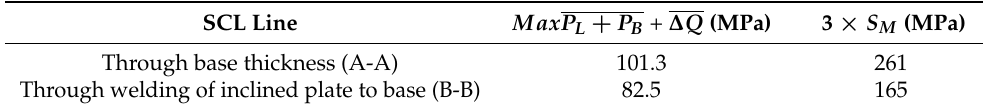
Table 2. Primary membrane + primary bending + secondary stresses in the SCL lines of the TLIC door (Al 6061 T6). SCL Line MaxP L + P B + ∆ Q (MPa) 3 × S M (MPa) Through base thickness (A-A) 101.3 261 Through welding of inclined plate to base (B-B) 82.5 165